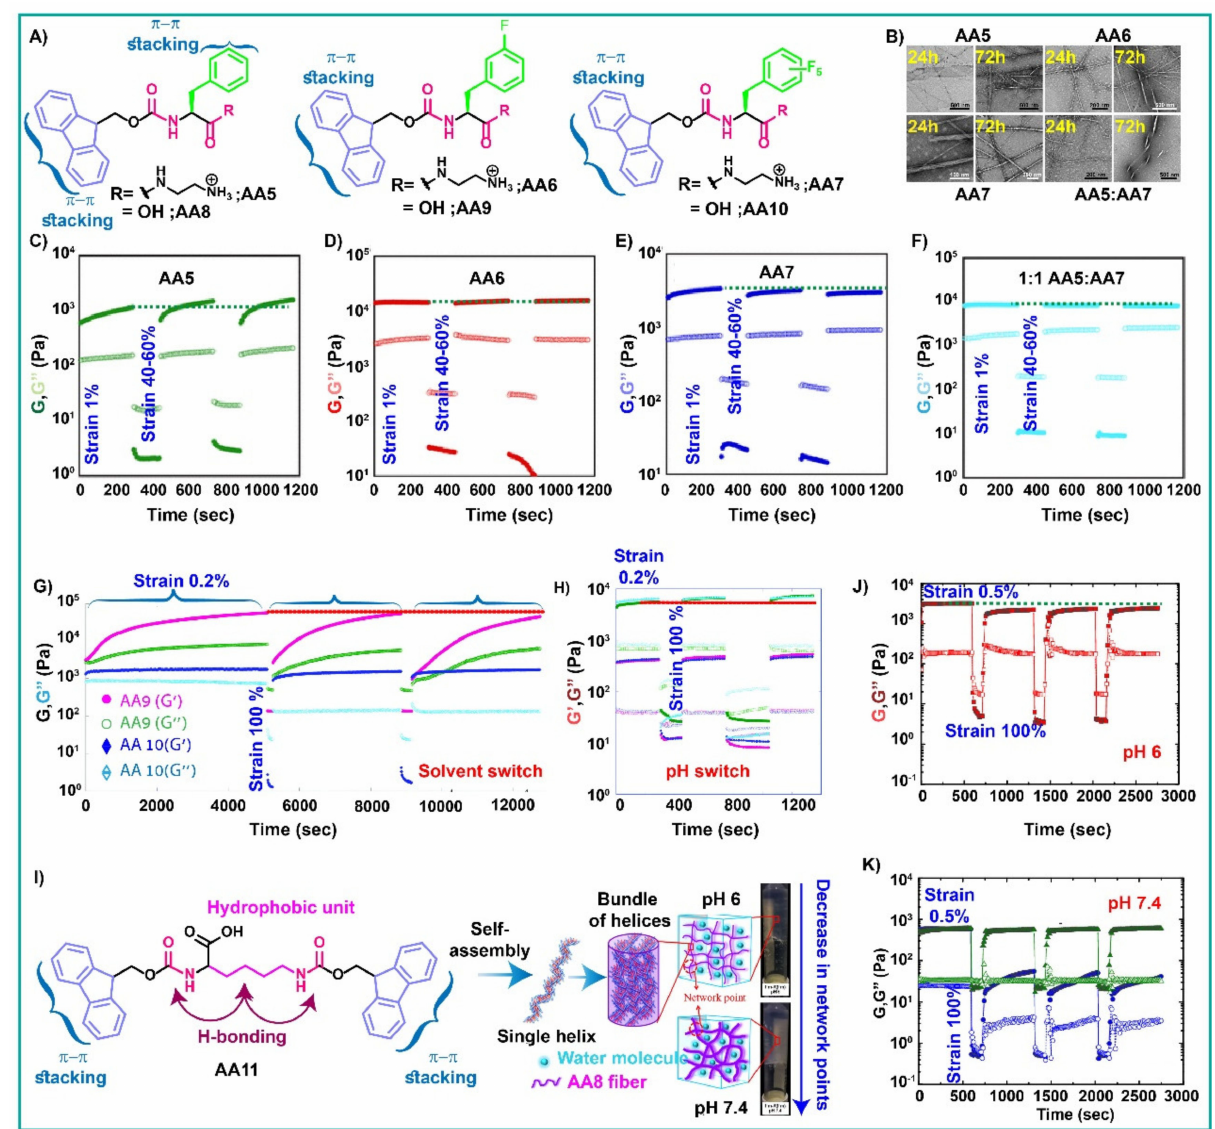
Figure 2. ( A ) Molecular structure of the amino acid hydrogelators (AA5–AA10); redrawn from Refs. [53,68]. Copyright issue is not applicable here. ( B ) TEM images of the representative pure and co-assembled hydrogelators. ( C – F ) Step-strain rheological test of the representative hydrogel; repro- duced with permission from Ref. [53] Copyright (2019) American Chemical Society. ( G , H ) Thixotropy cycle of the amino acid gelators; reproduced with permission from Ref. [68]. Copyright (2020) Royal Society of Chemistry. ( I ) Schematic illustration of possible self-assembly and network formation of AA8 hydrogelator. ( J , K ) Rheology experiment confirming the thixotropic behavior of AA8 at pH 6 and 7.4, respectively. Reproduced with permission from Ref. [69]. Copyright (2020) American Chemical